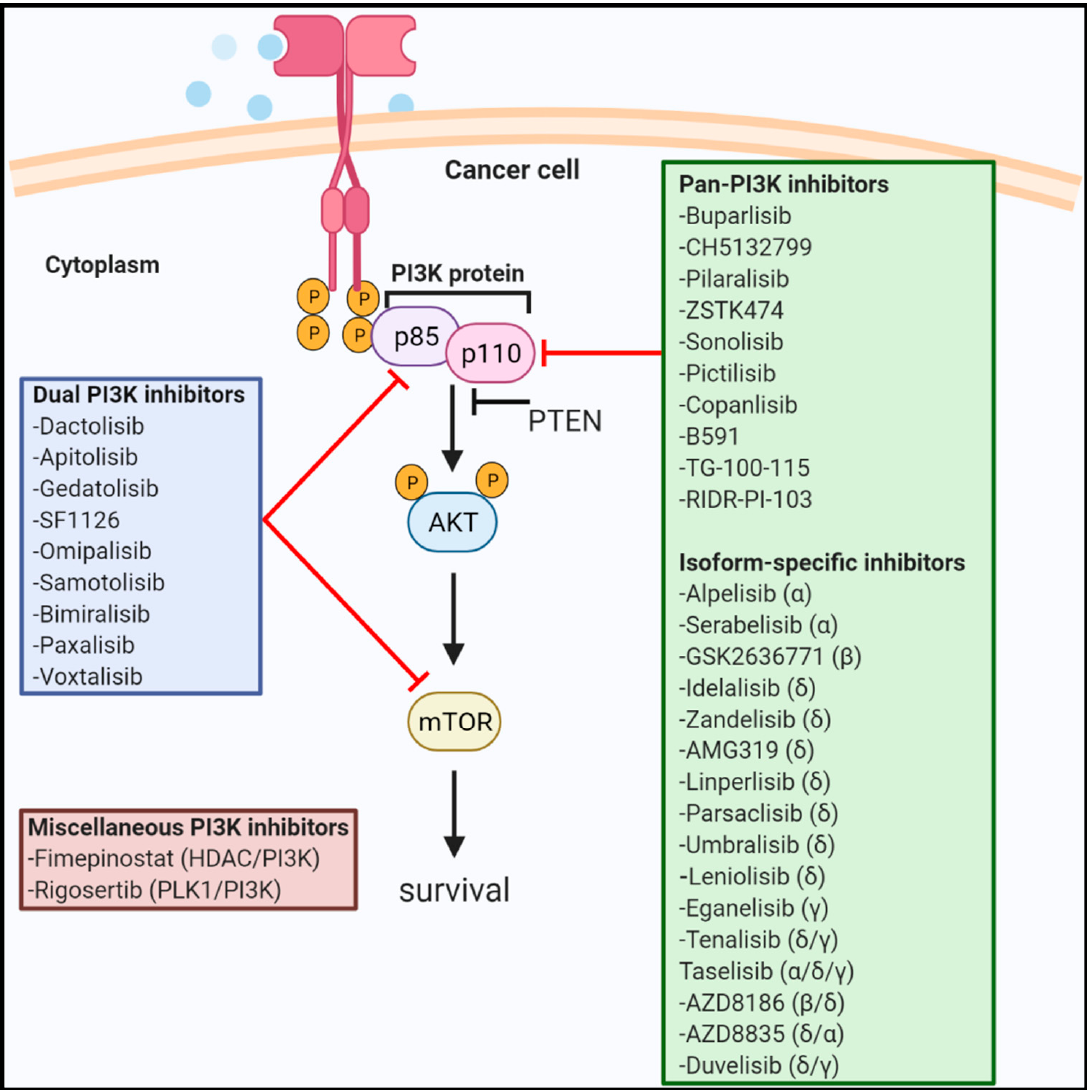
Figure 1. PI3K inhibitors: pan, isoform-specific and dual PI3K/mTOR inhibitors to treat patients with different cancers (created with Biorender; www.biorender.com accessed on 20 March 2021).